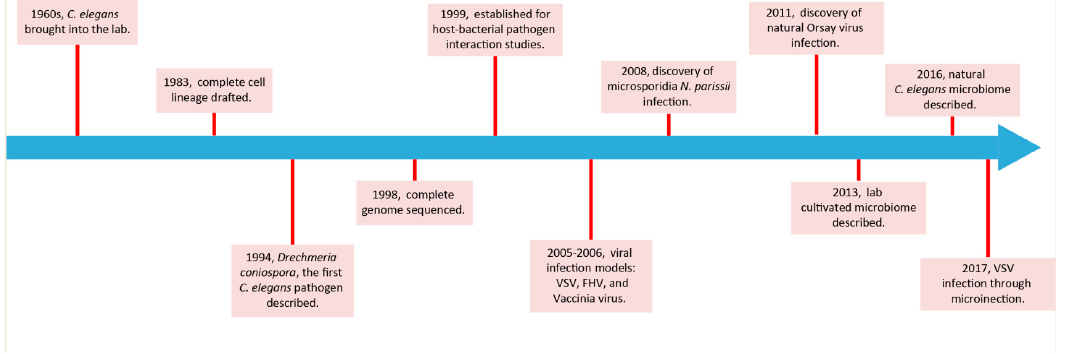
Figure 1. Milestones relevant to host-pathogen interaction studies in C. elegans . Table 1. Pathogen–host interaction in the C. elegans intestine.